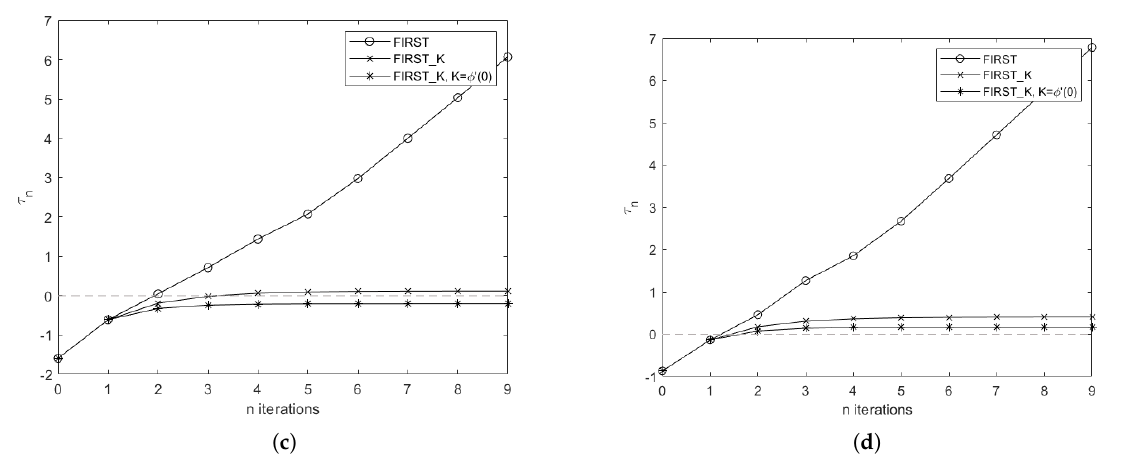
Figure 10. ( a ) Convergence of the sequence τ n for the signal in Figure 1: τ 0 : ρ = 0.10; ( b ) Convergence of the sequence τ n for the signal in Figure 2: τ 0 : ρ = 0.10. For fixed u , all points satisfy the